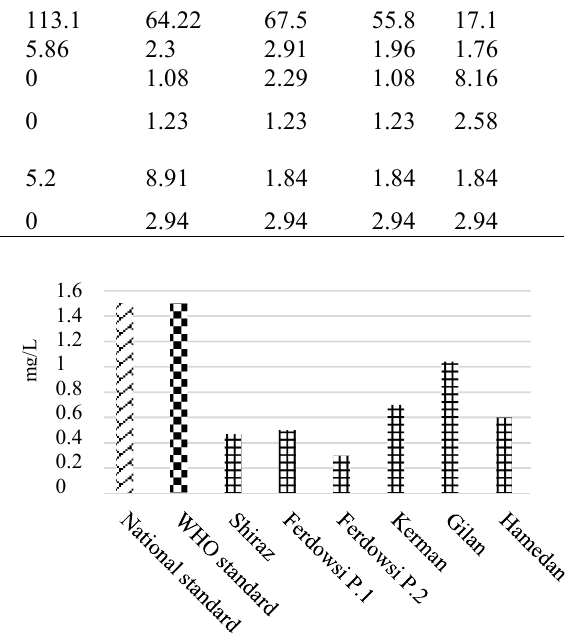
Fig. 3. Comparison of the amount of fluoride to the national and global standard